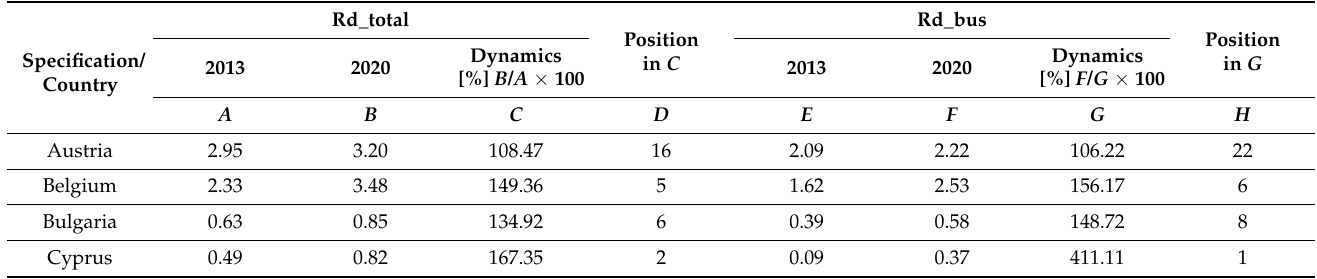
Table A3. R&D expenditures in the economy (as % of GDP) and R&D expenditures in the business sector (as % of GDP)—comparison 2013 and 2020 in the